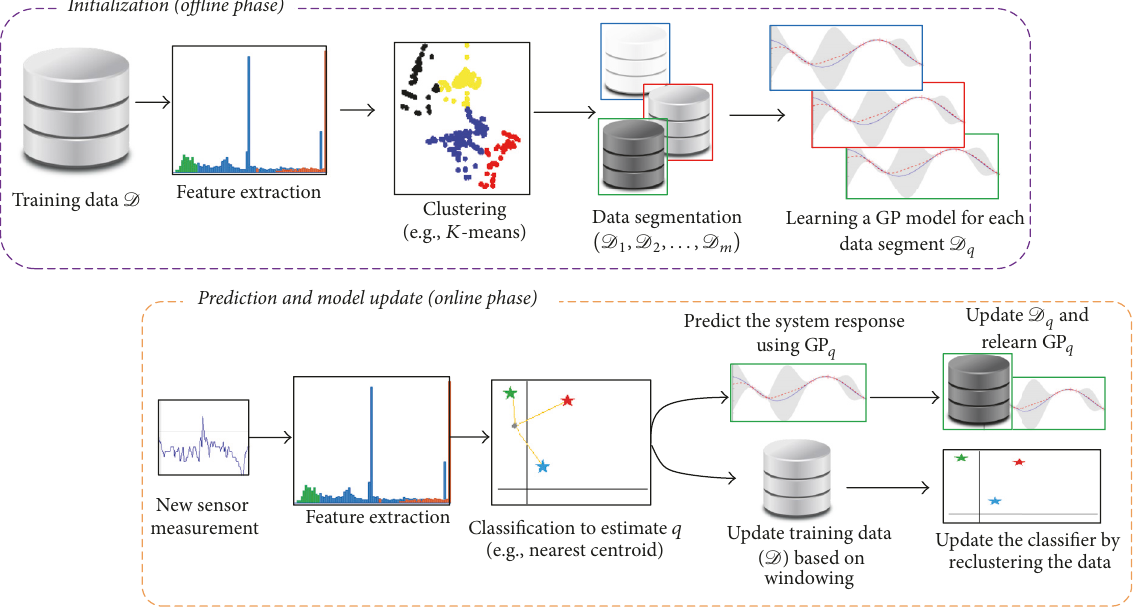
Figure 2: Clustering-based online model learning for